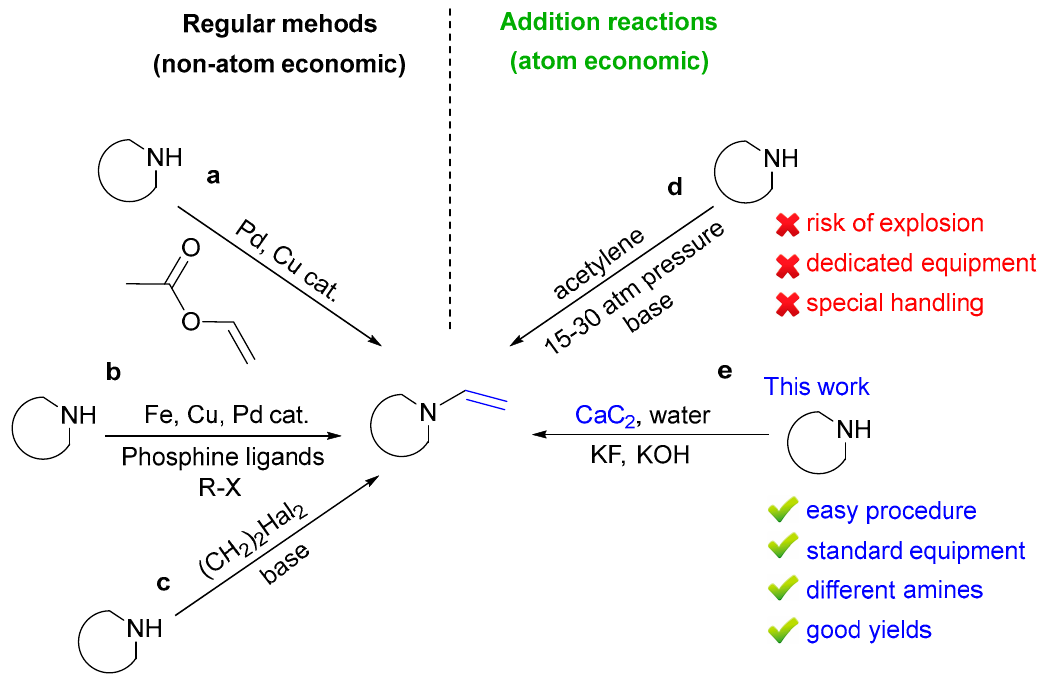
Scheme 1. Synthetic procedures to access N ‐ vinyl derivatives.